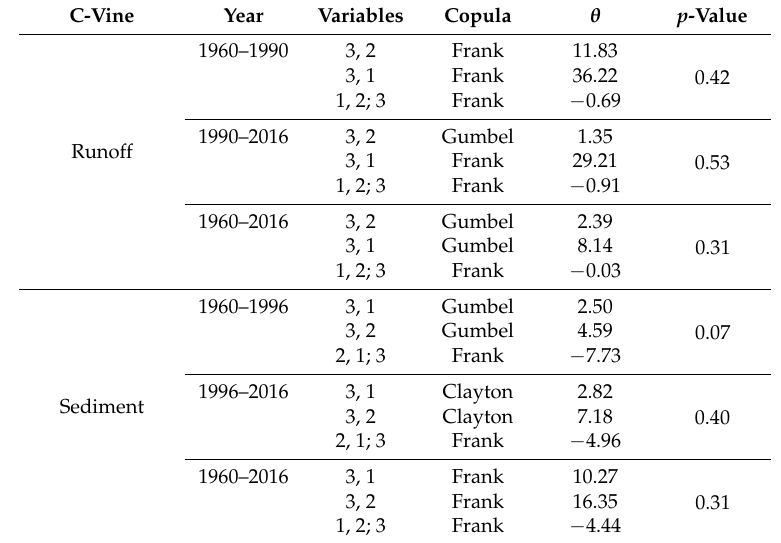
Table 2. Selection and test of joint distribution functions of the runoff and sediment yields of the three